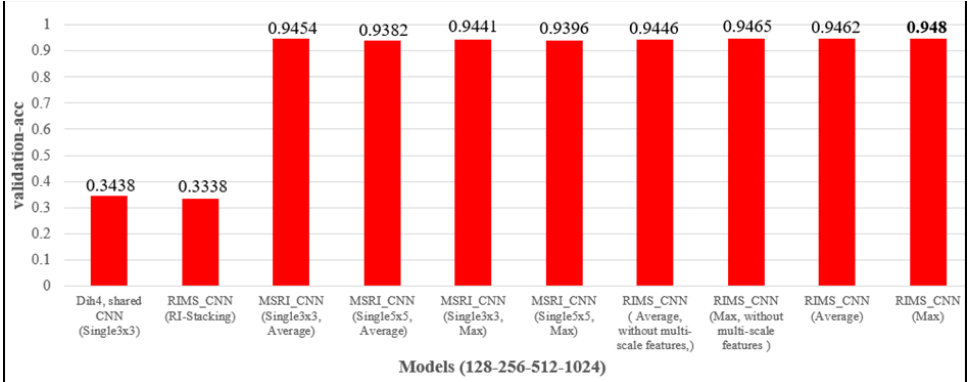
Figure 25. Evaluating different feature-extracting structures on the fixed-angle rotated FASHION- MNIST.